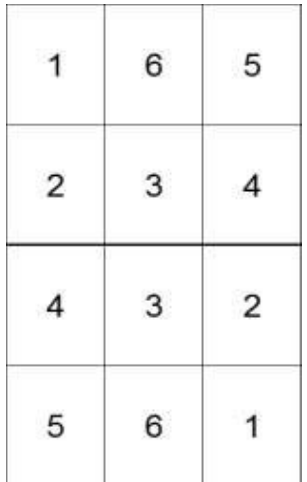
Figure 1. Six-area subdivision of the table. The thick line represents the